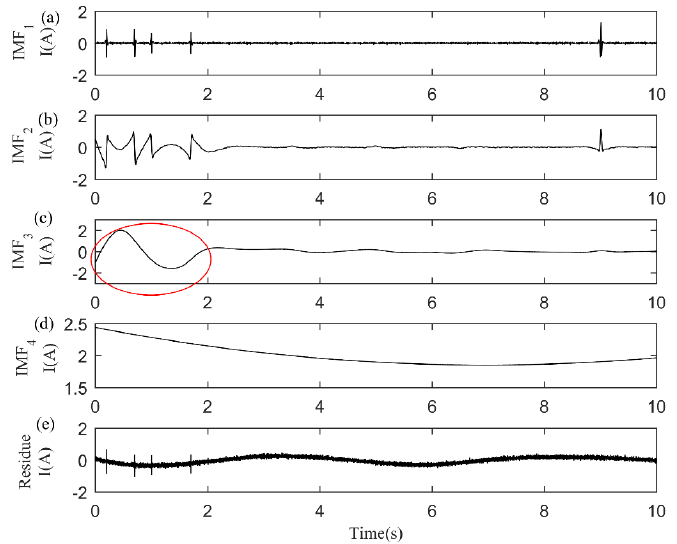
Figure 8. EEMD simulation signal decomposition results. ( a ) IMF 1 component; ( b ) IMF 2 component; ( c ) IMF 3 component; ( d ) IMF 4 component; ( e ) Residue.